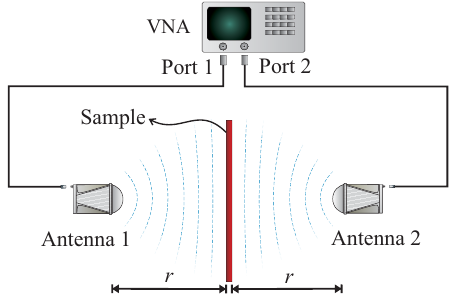
Figure 1. Representation of the transmission and reflection Free-Space Method. The sample is placed between two antennas, which are connected to the ports of the